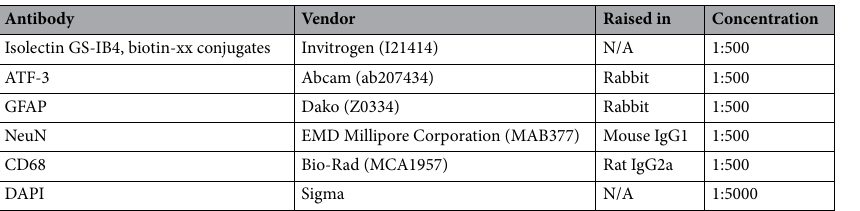
Table 1. Primary antibodies. All primary antibodies were made in the corresponding blocking/ permeabilization buffer. CaCl